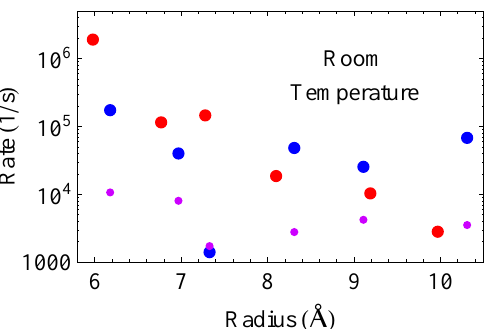
Figure 1. Calculated rates of radiative transitions for undoped (small violet dots), P-doped (big blue dots) and Li-doped (big red dots) Si nanocrystals.